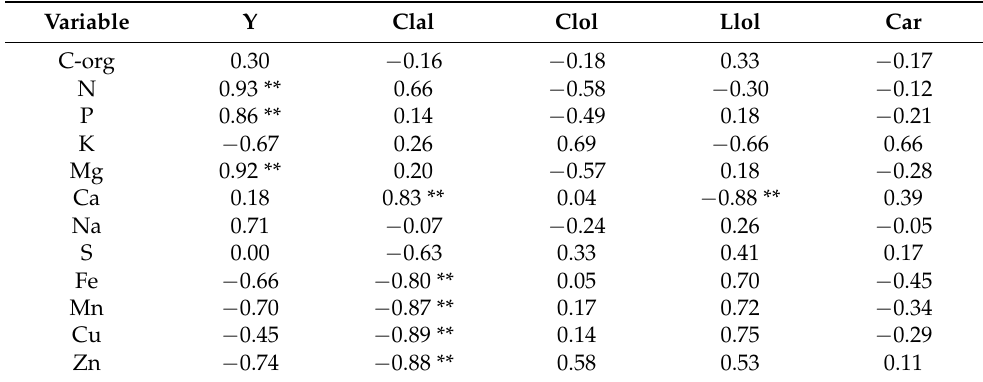
Table 11. Pearson correlation coefficient of kaffir lime leaves essential oil (yield and main composition) and plant macro- and micro-nutrient status.